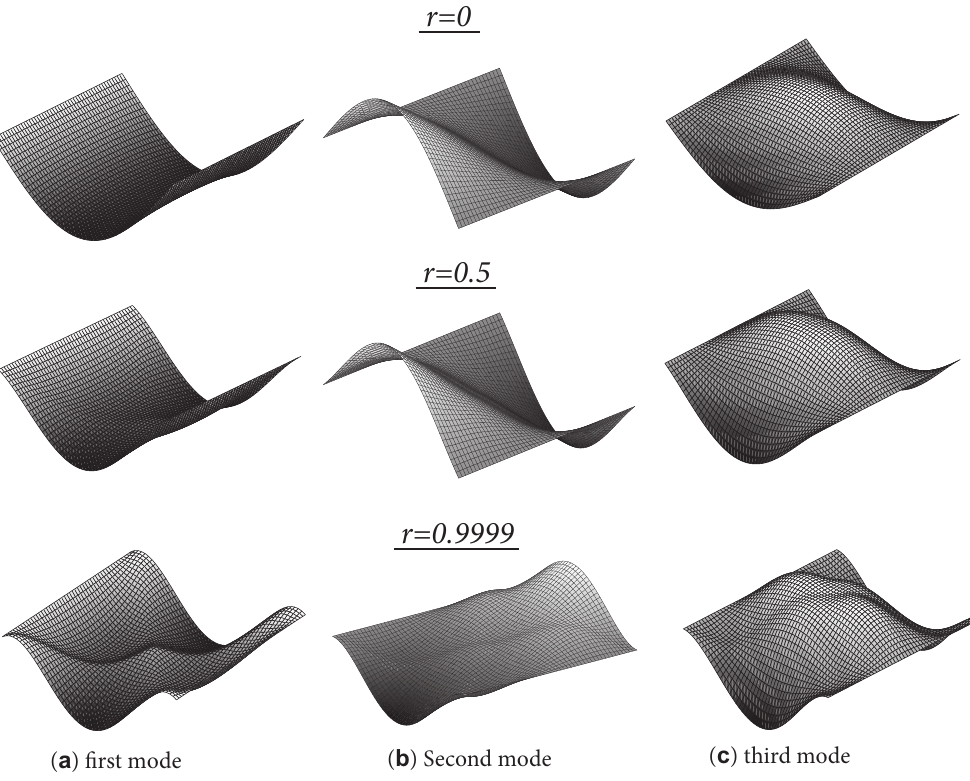
Figure 3. Mode shapes of a square orthotropic plate with different rotational restraints. ( a ) first mode; ( b ) second mode; ( c ) third